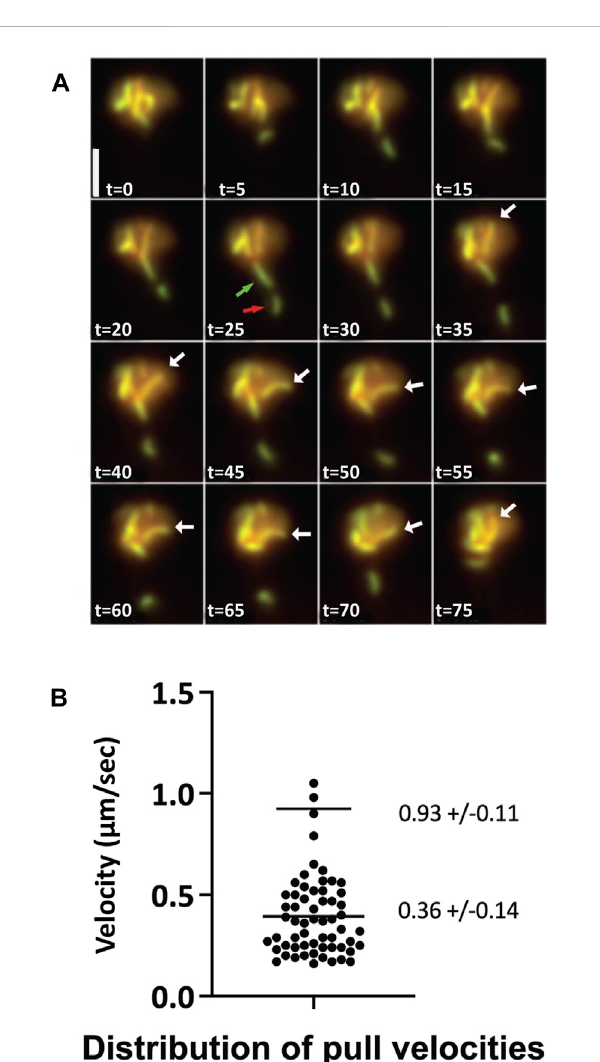
Chromosome dynamics and sporulation observed in zip3 Δ (A) Max-sum projections from a 3-D time series at 5 s intervals of a zip3 Δ cell expressing Zip1-GFP during pachytene. An example of telomere-led chromosome motion is illustrated by a single long chromosome moving between t = 35 s to t = 75 s (white arrow). Maverick chromosomes (green and red arrows). Scale bar — 2 µm. (B) Distribution of velocity measurements for telomere-led motions of pachytene chromosomes from nuclei expressing Zip1-GFP in zip3 Δ . Averages and STDs are given for the low and high velocity clusters. N =